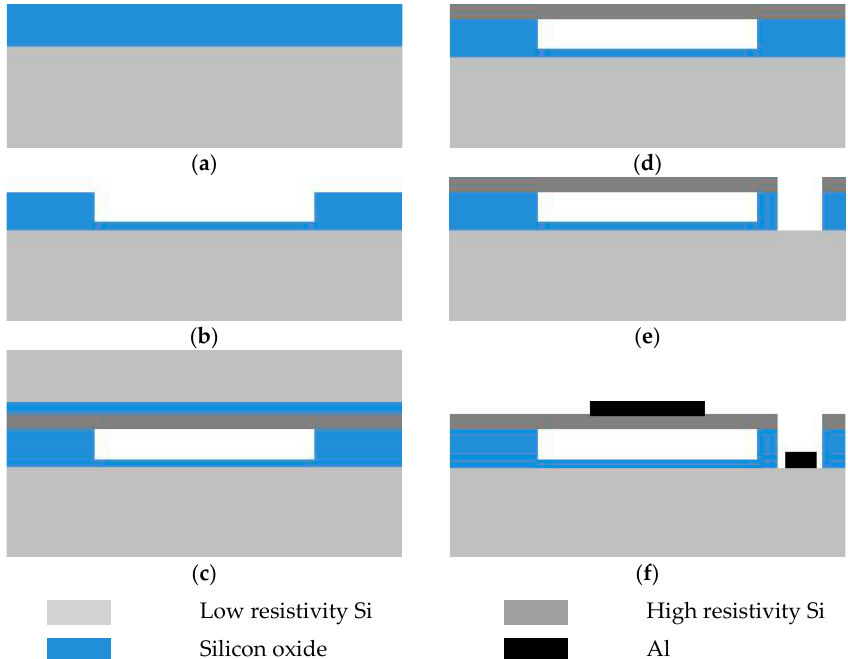
Figure 5. Process flow of micromachined ultrasonic transducer (CMUT) fabrication. ( a ) Thermal oxidation; ( b ) Dry etching for cavity; ( c ) Wafer bonding for the substrate with silicon on insulator (SOI); ( d ) Removing the silicon substrate and the buried oxide of the SOI; ( e ) Silicon and oxide etching for ground contact; ( f ) Aluminum deposition for the top and bottom electrodes.